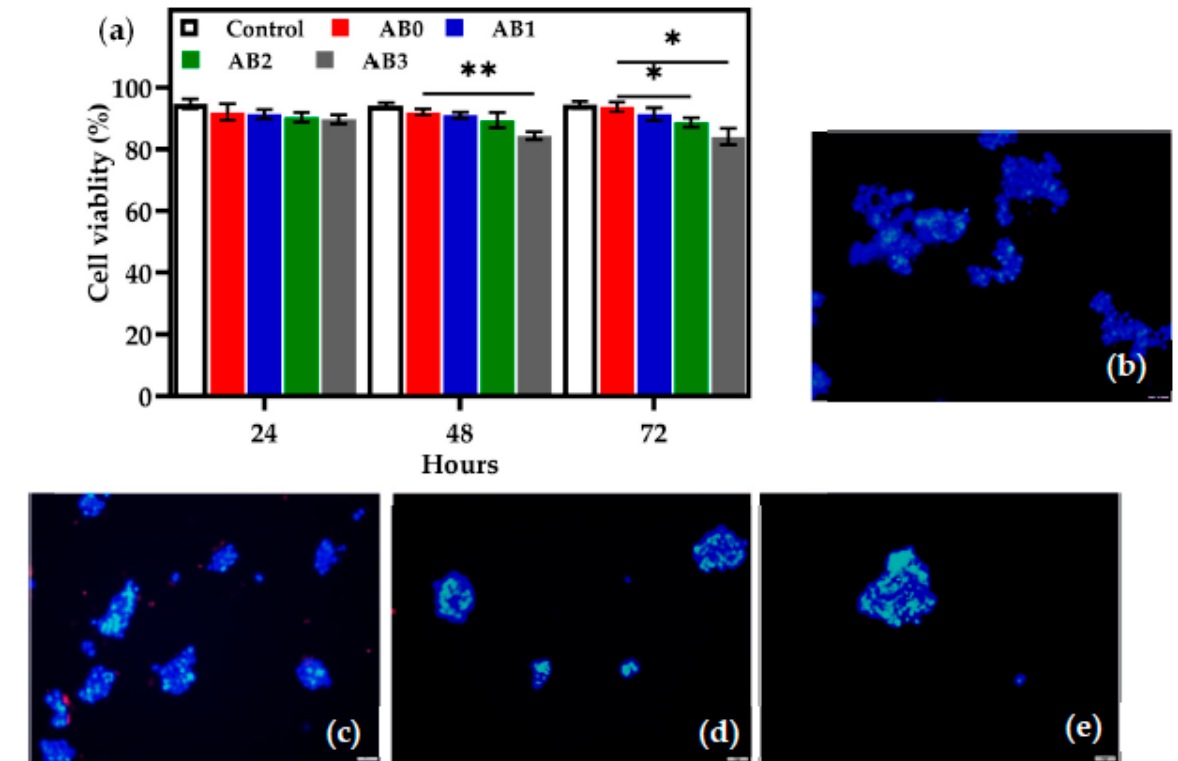
Figure 10. ( a ) Cell viability of control and AB scaffolds (* p < 0.05, ** p < 0.01; n = 3); fluorescent images of ( b ) AB0; ( c ) AB1; ( d ) AB2 and ( e ) AB3.